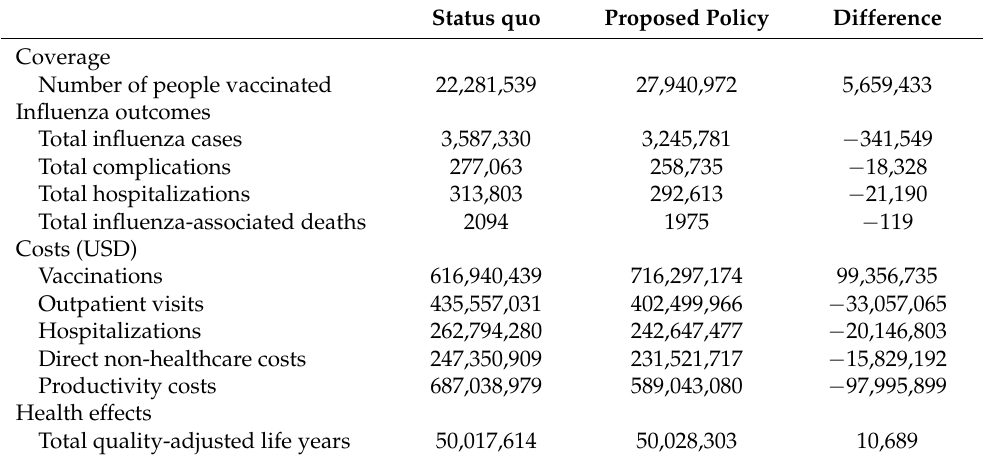
Table 4. Base case results of status quo and adding vaccination of those aged 50–64 years in Korea.